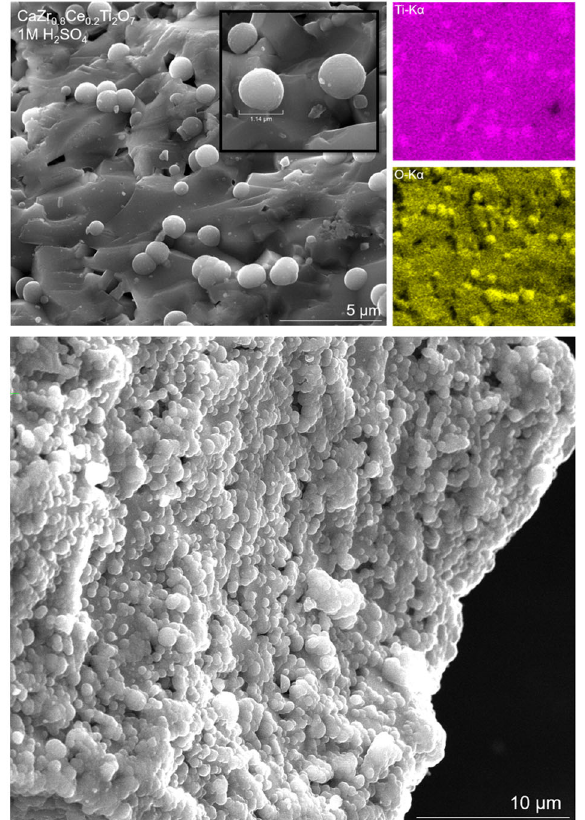
Fig. 5 SEM-EDS analysis of titanium-rich surface precipitates observed on CaZr 0.80 Ce 0.20 Ti 2.00 O 7 particulates recovered from 1 M H 2 SO 4 solution at 90 °C for 14 days (cumulative leaching time). The upper SEM image has a scale bar of 5 µm and the spherical precipitate is ~1 µm in size. The EDS images are Ti (pink) and O (yellow). The lower image has a scale bar of 10 µm.